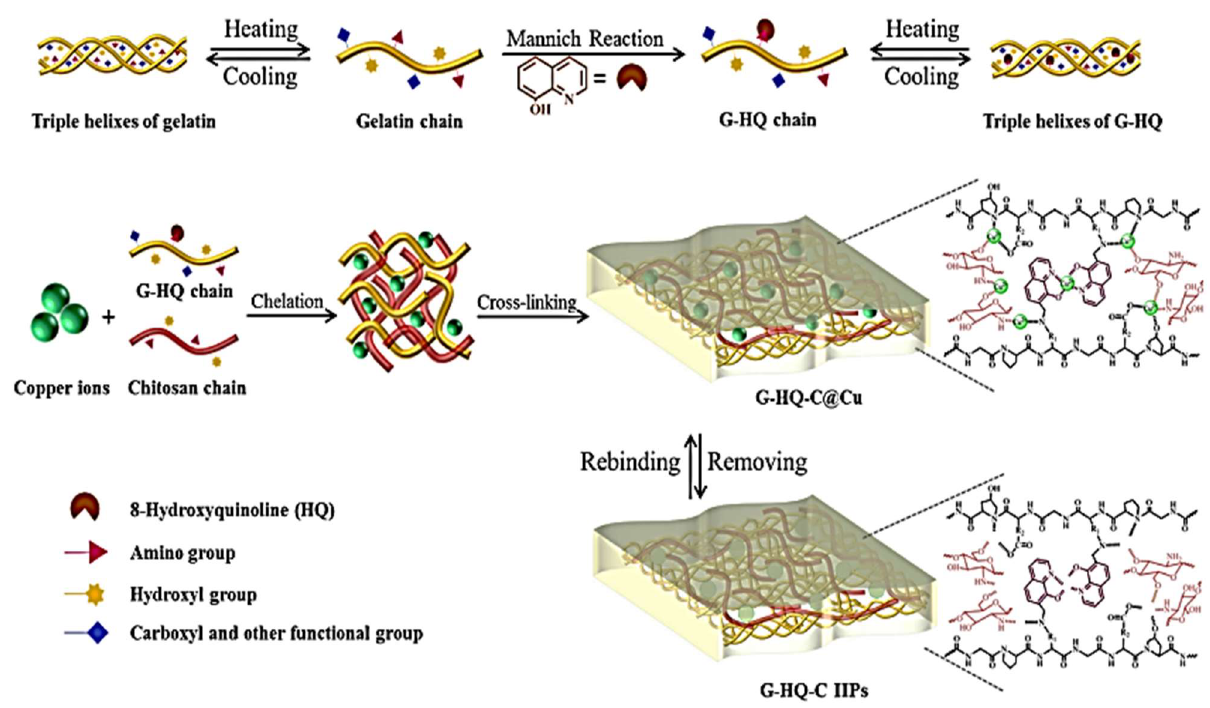
Figure 4. Schematic illustration of the preparation process for gelatin-hydroxyquinoline-Chitosan/ion-imprinted polymers for copper ions [52]. (Reproduced under permission from Elsevier, doi:10.1016/j.jcis.2019.01.081).